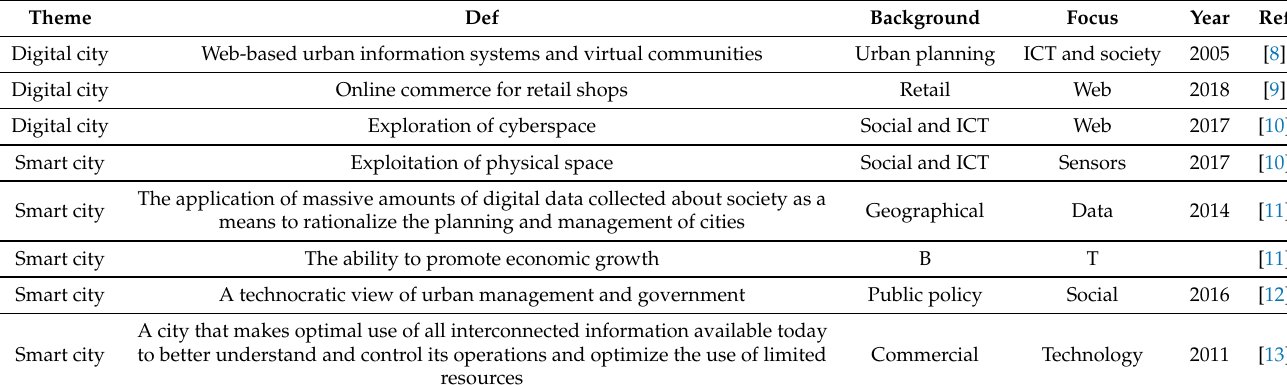
Table 1. Variations in smart/digital city